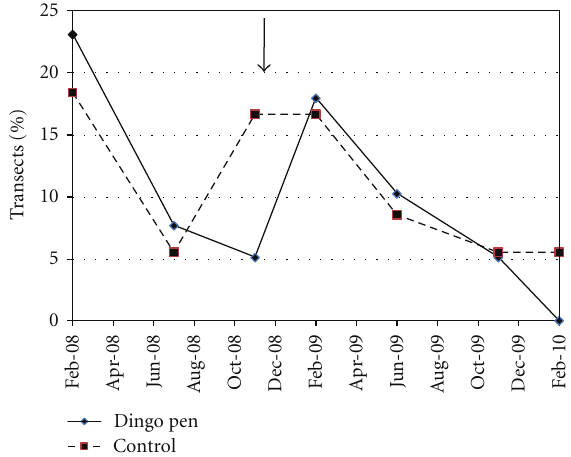
Figure 3: The percentage of transects (Dingo Pen n = 39, control n = 38) with cat tracks recorded at sites within the Dingo Pen and control area. Cats were added to the Dingo Pen between April and October 2009 and to the control area in October 2009. The pen was completed in November 2008, and the arrow indicates when dingoes were